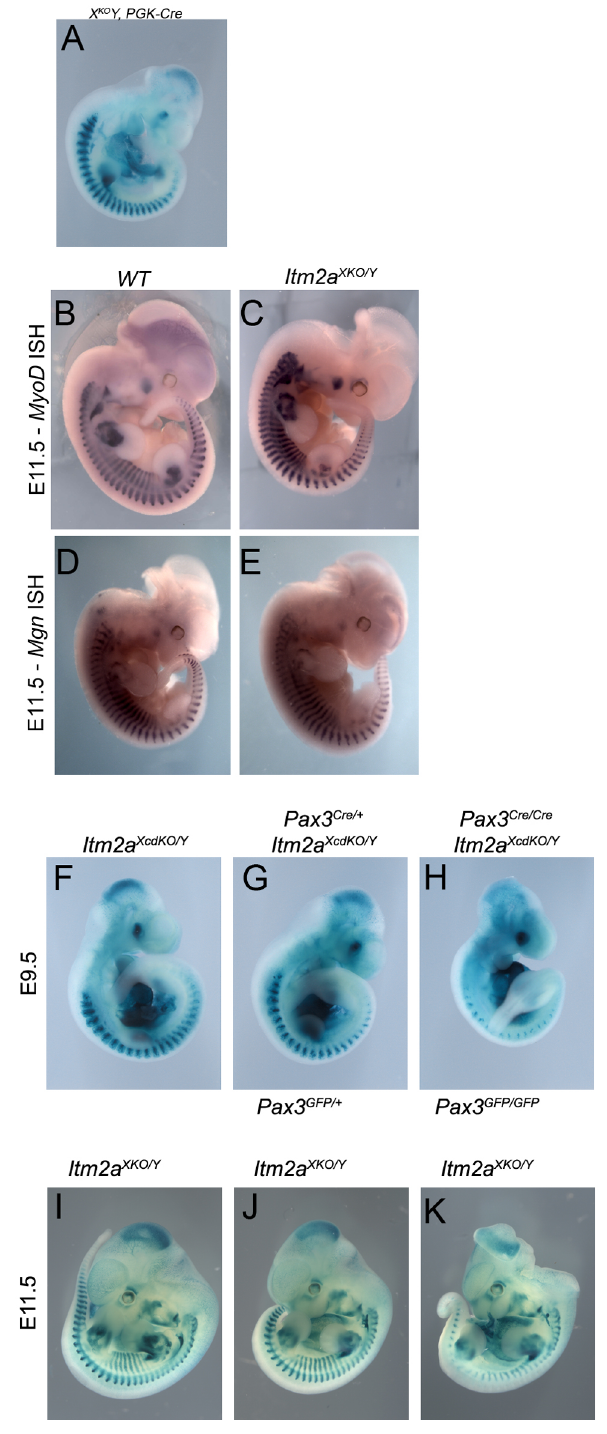
Figure 3. Phenotypic analysis of Itm2a mutant embryos. A, X-Gal staining of an Itm2a XKO/Y ; PGK-Cre embryo at E10.5. B–E, Whole mount in situ hybridization with a MyoD (B–C) and Myogenin (D–E) antisense riboprobe on control (WT) (B, D) and Itm2aXKO/Y embryos at E11.5. In A, C and E the mice were crossed with the PGK-Cre line to delete the floxed Itma2 allele. F–H, X-Gal staining of Itm2a XcdKO/Y (F), Itm2a XcdKO/Y ; Pax3 Cre/ + (G) and Itm2a XcdKO/Y ; Pax3 Cre/Cre (H) embryos at E9.5. I–J, X-Gal staining of Itm2a XKO/Y (I), Itm2a XKO/Y ; Pax3 GFP/ + (J) and Itm2a XKO/Y ; Pax3 GFP/GFP (K) embryos at E11.5.